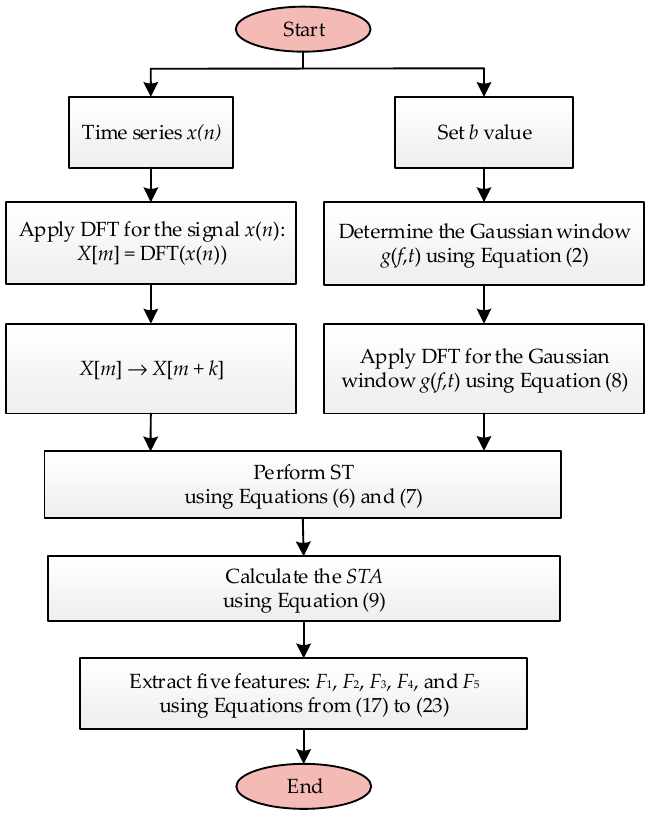
Figure 1. The proposed Stockwell transform (ST) algorithm.